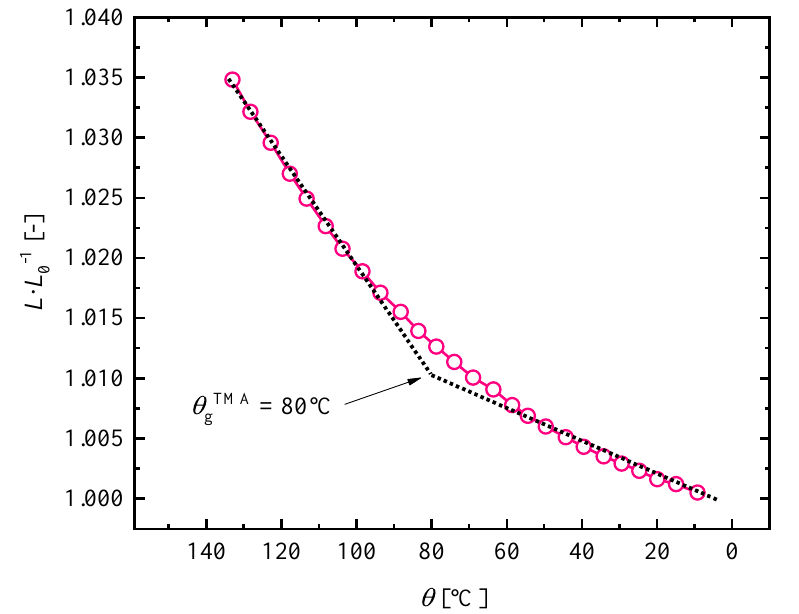
Figure 5. Evolution of thermal strains of Estane samples during cooling from 120 to 0 ◦ C. A piece- wise linear function is fitted to the recorded thermal expansion data. The results are averaged out of three test